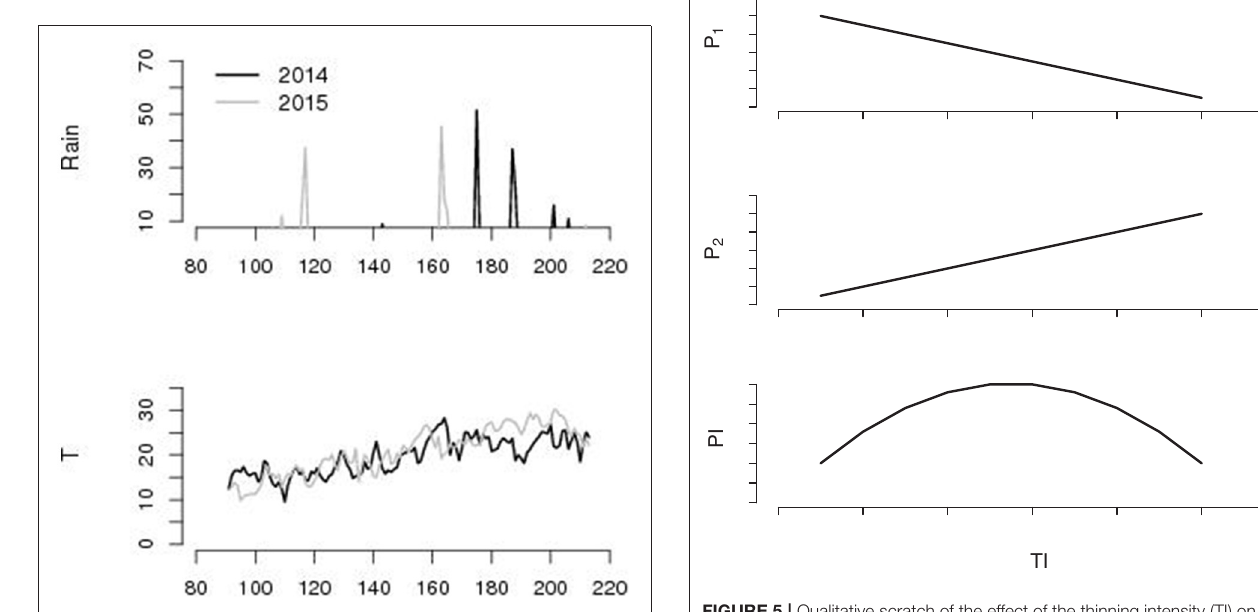
FIGURE 5 | Qualitative scratch of the effect of the thinning intensity (TI) on the probability of infection (PI) of the host fruit. The probability P 1 that an airborne spore produced by an infectious fruit is deposited on a susceptible fruit decreases with TI that decreases fruit density; the probability P 2 that a fruit in contact with Monilinia spp. spores develops infection increases with TI since lower fruit density determines higher fruit growth rates and cuticle cracking; the probability of an healthy fruit to become infectious (PI) results from the product P 1 × P 2 that is a concave function of